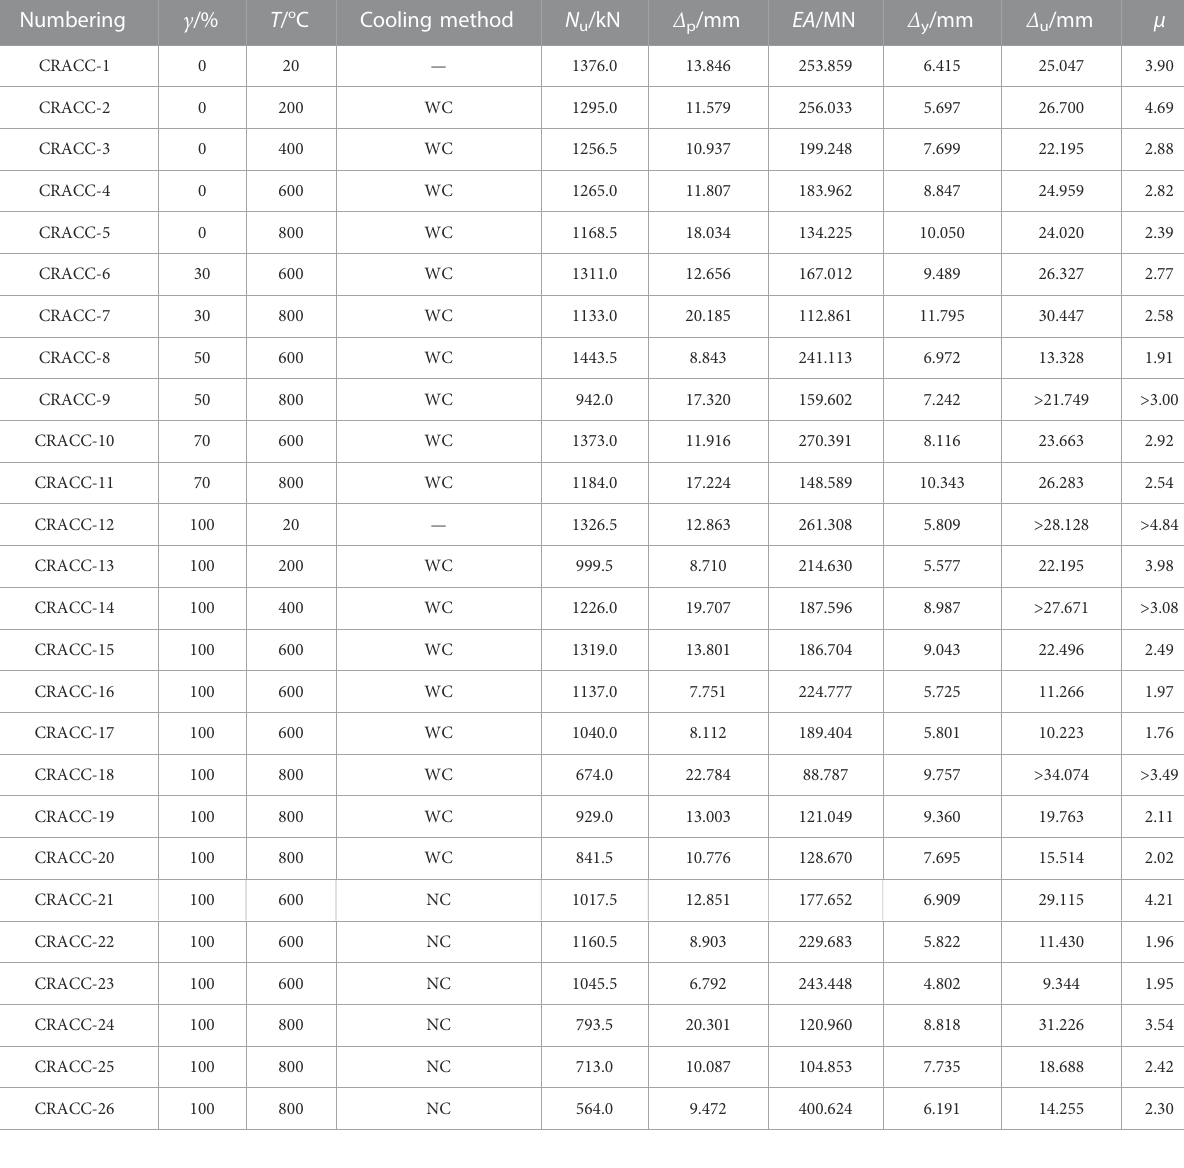
TABLE 4 Main parameters of feature points.